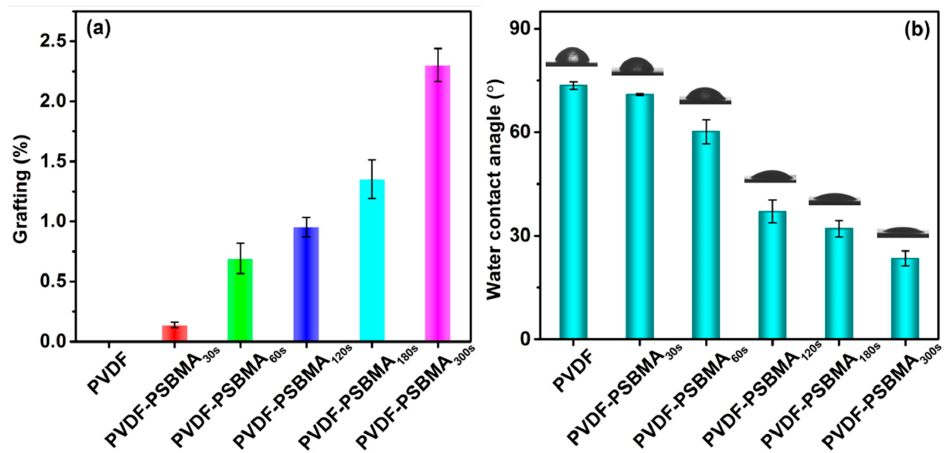
Figure 3. ( a ) The influence of the PVDF membrane modified with SBMA monomer. ( b ) The water contact angle of PVDF and PVDF-modified membrane surface.